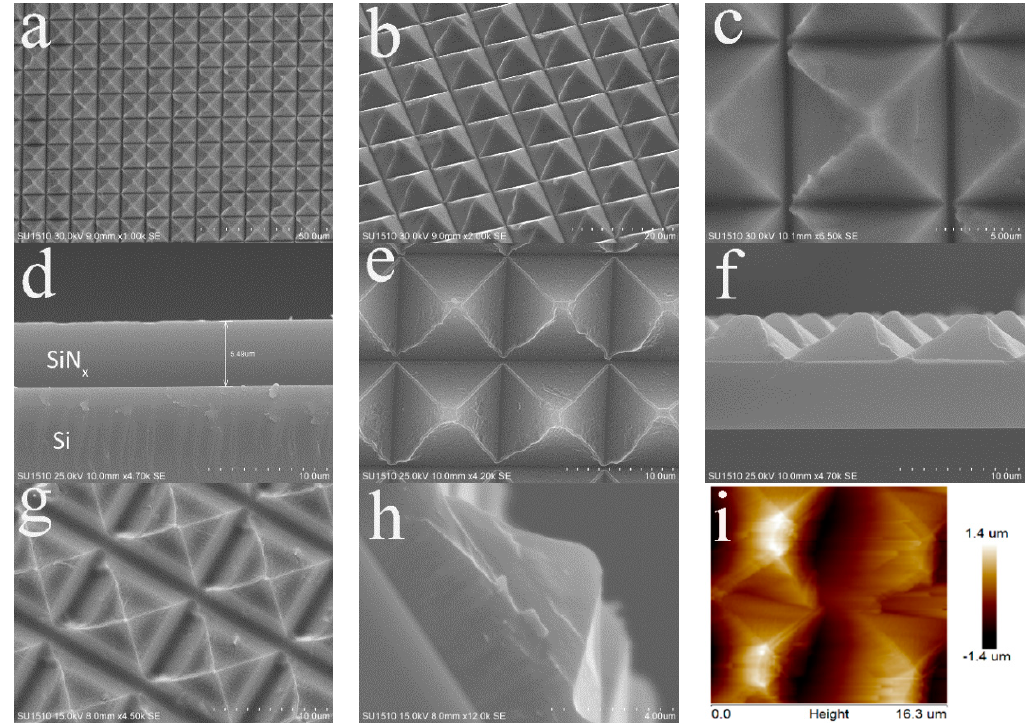
Figure 5. SEM images and AFM images of the samples with the micro-pyramids texture. ( a – c ) An array of micro-pyramids is obtained with the SPDT process; ( d ) a 5.49 μ m thick SiN x layer with low stress is produced by the PECVD method; ( e , f ) a micro-pyramid grid in the NIL resist is obtained and ( g – i ) a final micro-pyramid texture in the SiN x film is generated.